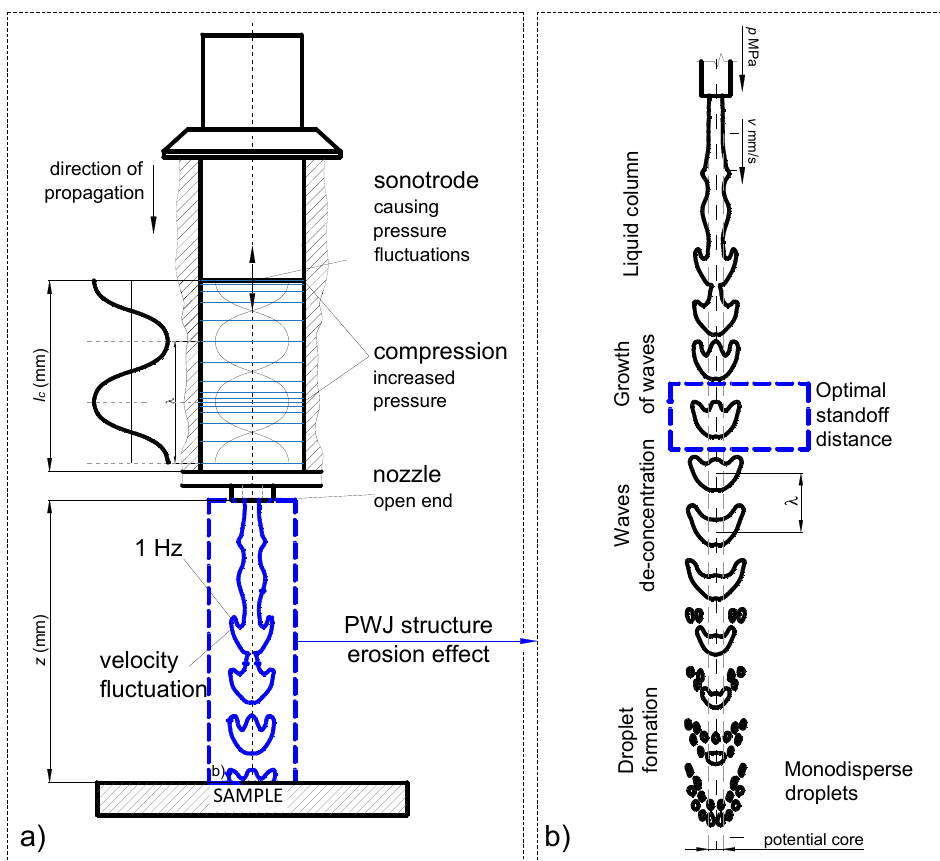
Figure 3. Experimental setup: ( a ) schematic figure of the device; ( b ) standoff distance estimation for water droplet use.